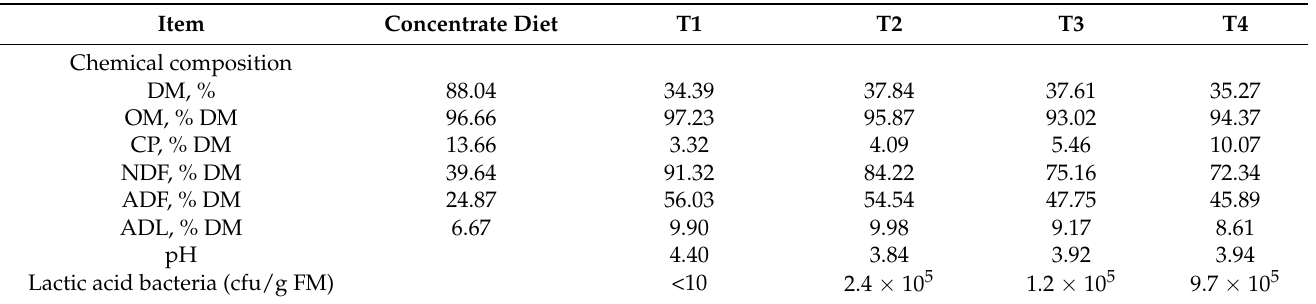
Table 1. Chemical compositions, volatile fatty acids, pH, and lactic acid bacteria of the concentrate diet and fermented sugarcane bagasse.